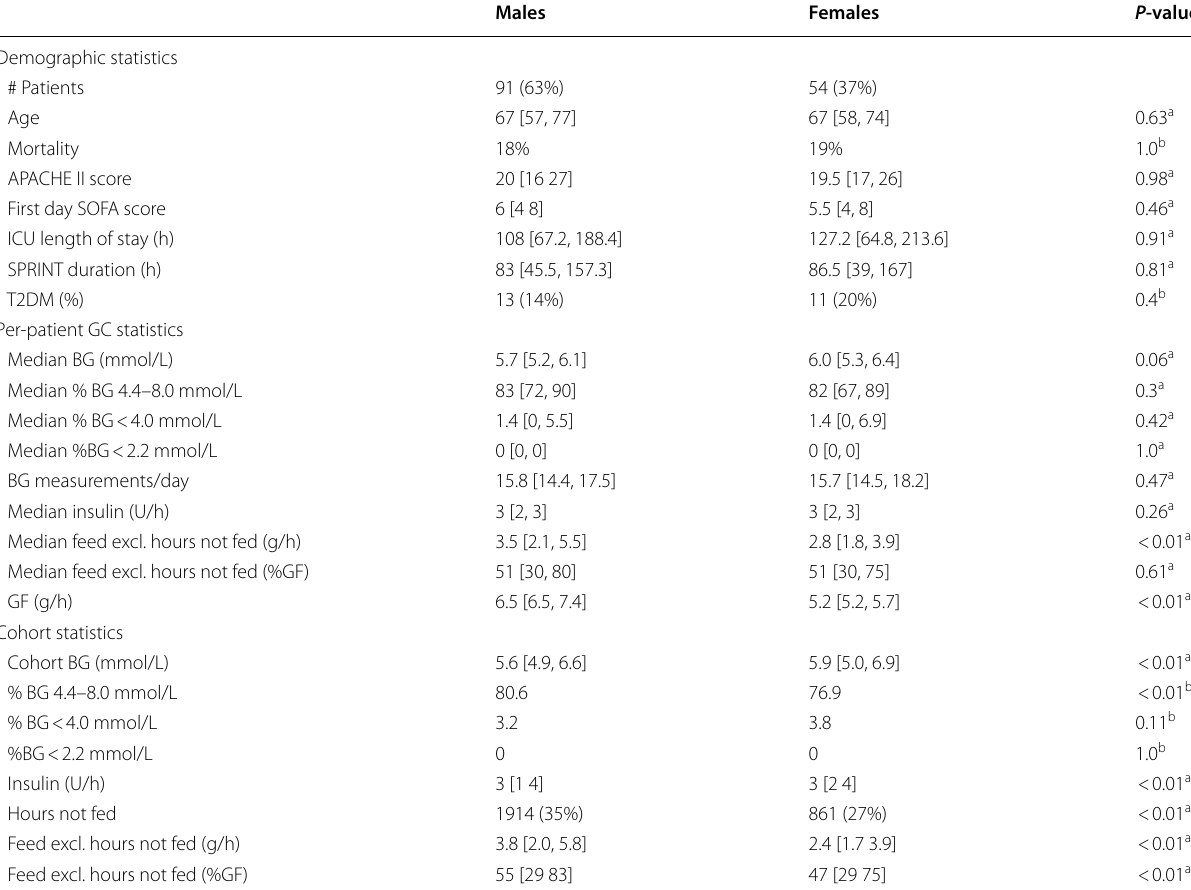
P -values are not adjusted for multiple comparisons. Median [IQR] is given where appropriate. T2DM BG blood glucose. BG is hourly resampled to allow fair comparison. =